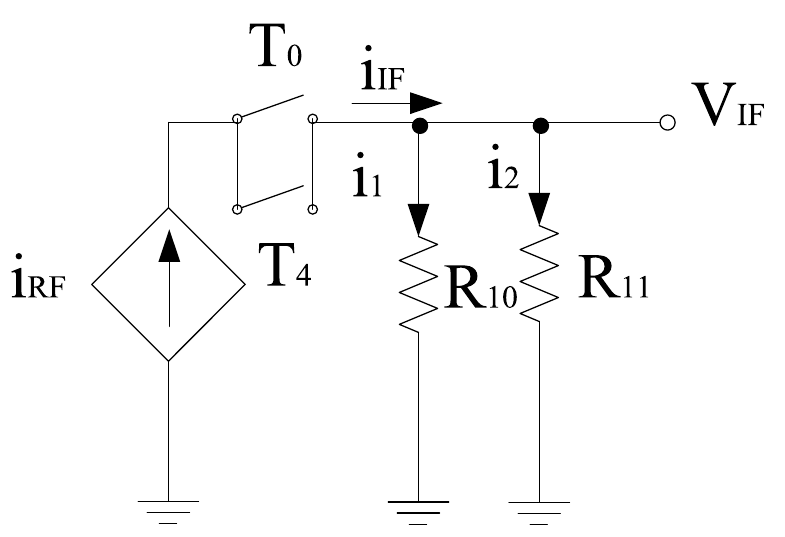
Figure 6. Equivalent small signal model for LO